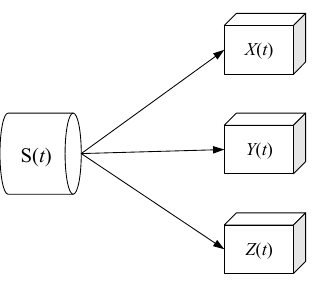
Figure 3. Different types of sensors measure the same signal source. Table 1. Spatial location parameters of three different sensors.